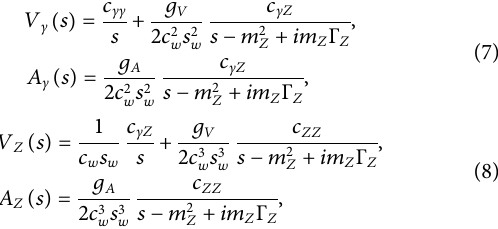
FIGURE 6 ALP decay processes at